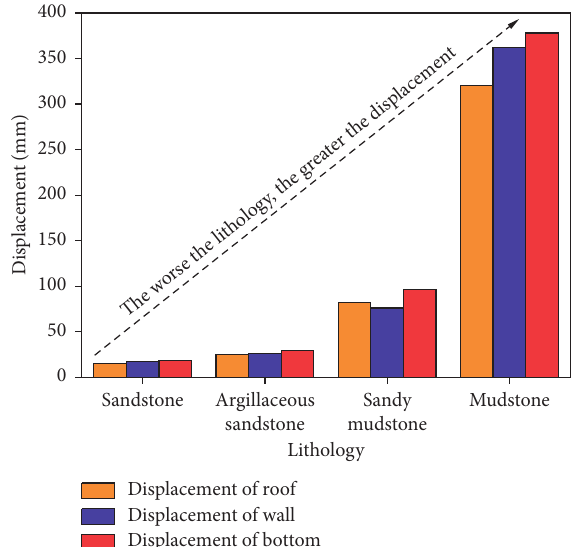
Figure 11: Relationship between lithology and displacement of roadway surrounding rock.